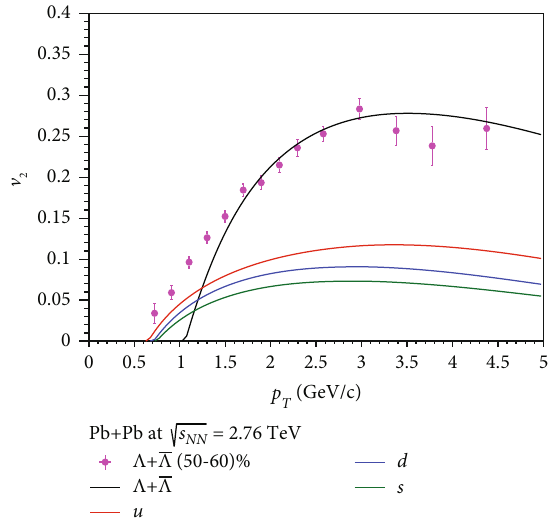
fi nal Λ p ffiffiffiffiffiffiffiffi = 2 : 76 TeV . s NN